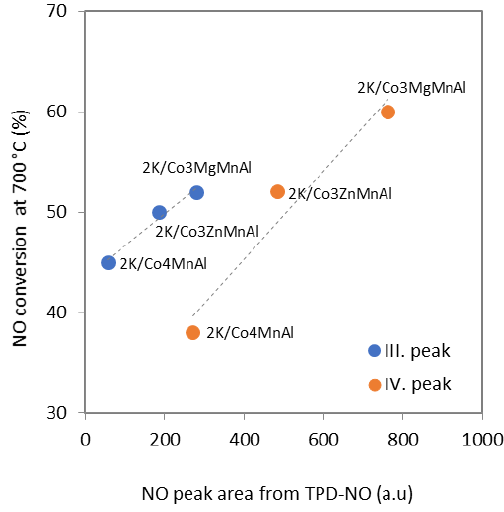
Figure 12. Dependence of NO conversion on NO peak area from TPD-NO.